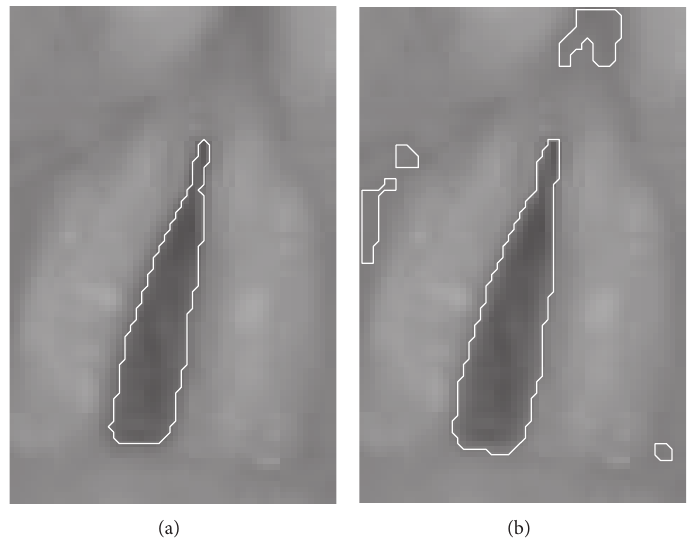
Figure 18: Segmentation results. (a) Proposed method. (b) The method of [7].